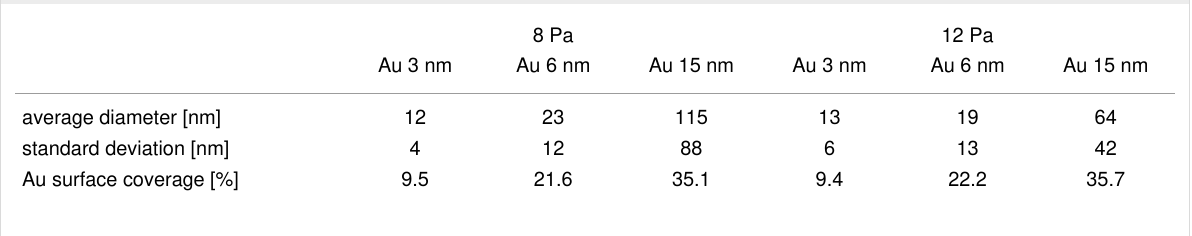
Table 1: Average equivalent diameter with standard deviation of Au NPs on TiO 2 films after